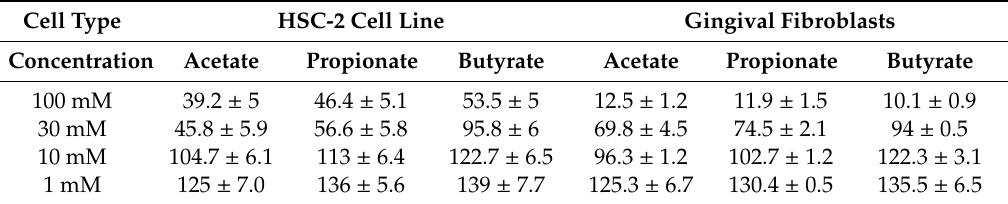
HSC-2 cells and gingival fibroblasts exposed at di ff erent concentration of SFCA. Cell viability is represented by formazan production indicated in percentage of unstimulated controls ± SD. Cells maintained their viability